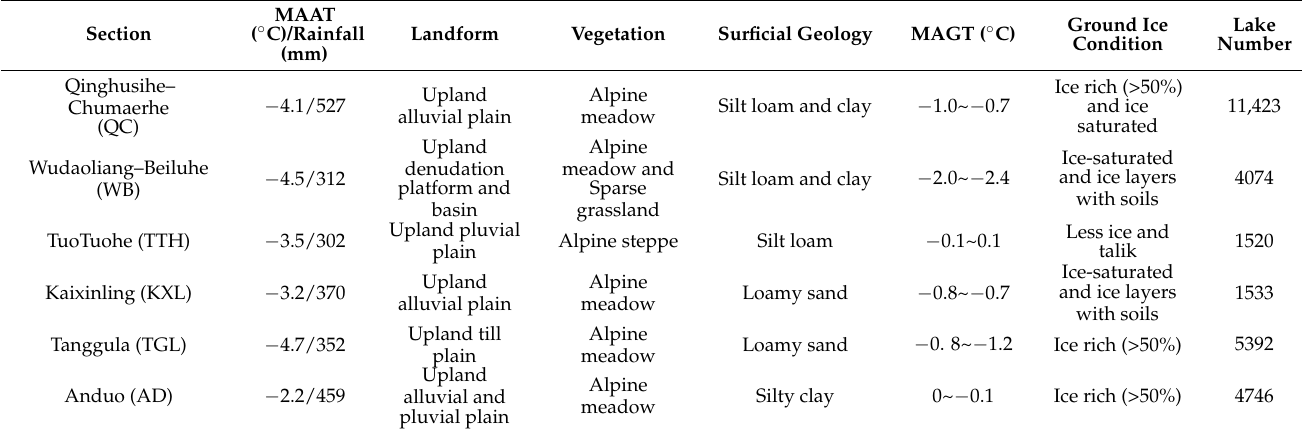
Table 1. Summaries of the characteristics of climate, landform, vegetation, surficial geology, and permafrost conditions in six